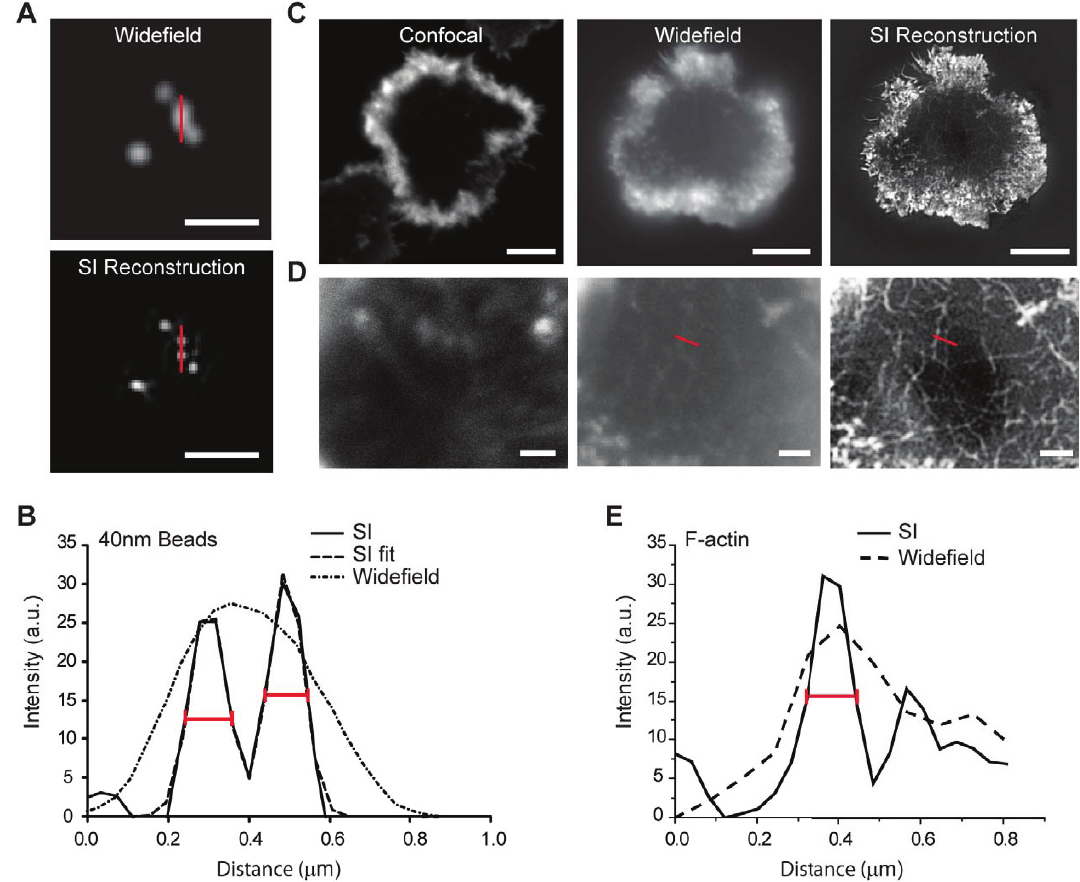
Figure 2. Structured illumination (SI) microscopy permits super-resolution imaging of F-actin at the natural killer cell synapse. ( a ) Widefield (top) and SI images (bottom) of 40 nm beads. Bar = 1 μm. ( b ) Plot profiles from the region marked by red bars in ( a ) show that two beads approximately 200 nm apart can be resolved only following SI reconstruction. Fitting of the curve with two Gaussians gives full widths at half maximum (FWHMs) (red bars on the graph) of 99 and 105 nm for each bead, respectively. ( c ) Confocal (left), widefield (middle), and SI image (right) of human primary natural killer cells activated on a surface coated with anti-NKG2D monoclonal antibody. Bars = 5 μm. ( d ) Regions at the center of the synapses in ( c ) are enlarged to demonstrate the increased level of detail in cortical F-actin structure when SI microscopy is used. Bars = 1 μm. ( e ) Plot profiles to directly compare the widefield and SI reconstructed image for the region indicated by the red bar shown in ( d ). Estimation of the FWHM (red bar on the graph) from the Gaussian fit of the SI data gives a resolution of approximately 115 nm. a.u., arbitrary units. Taken from